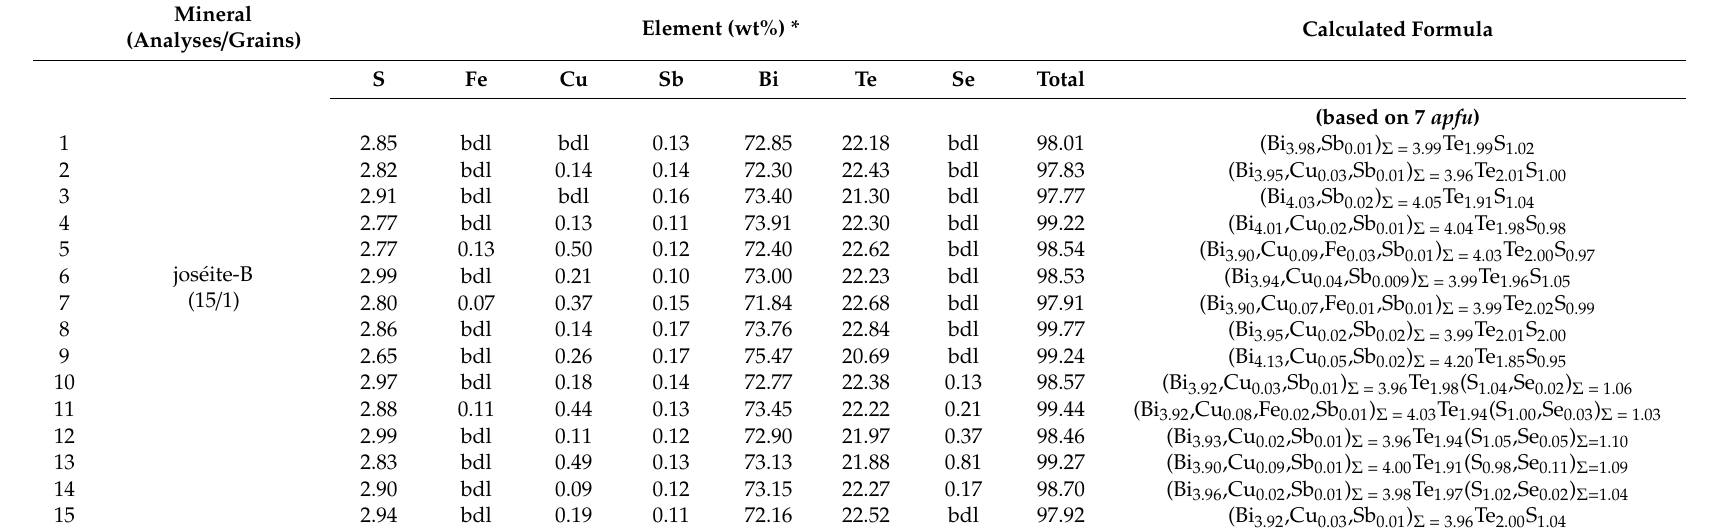
Table 3. Quantitative chemical data (wt%) for jos é ite-B from the Blidar Contact